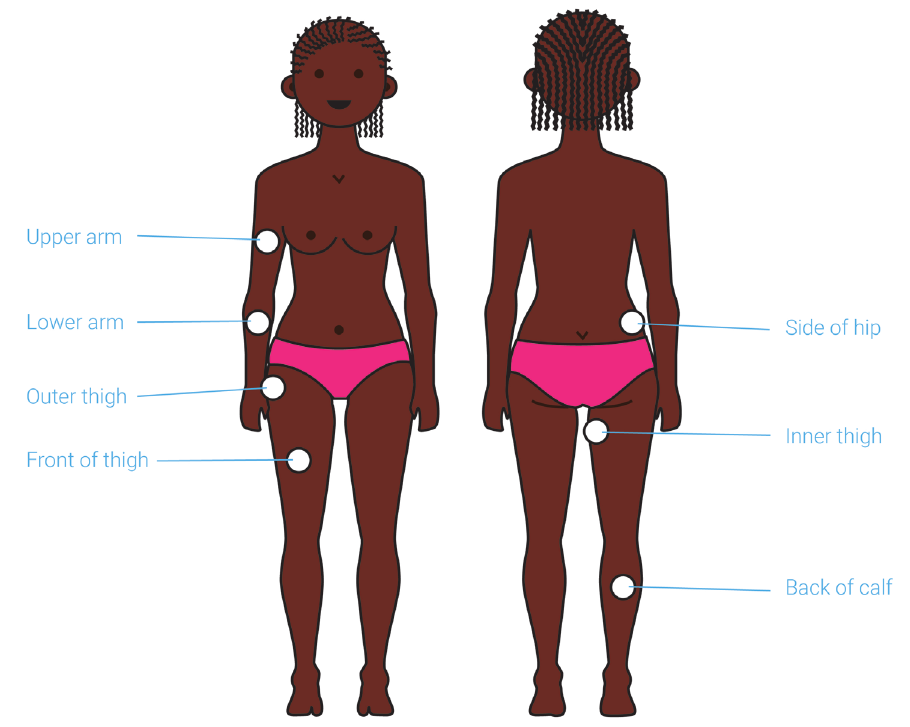
Figure 6. An illustration presented to participants to capture their views on the preferred anatomical site of application. The suitable anatomical sites for application are highlighted on this illustration. Participants were asked to identify their preferred site and explain their choice. This exercise helped identify the upper arm and front thigh as the preferred anatomical site for application of the proposed contraceptive delivery